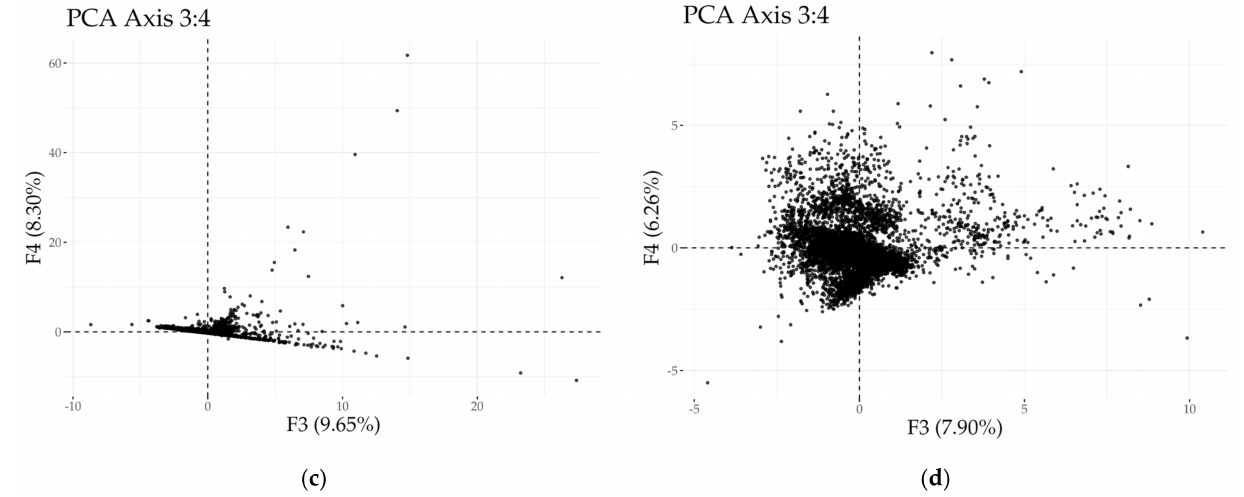
Figure 4. Distribution of the observations in factorial plans F1 − F2 and F3 − F4 for: ( a , c ) raw data; ( b , d ) log-transformed data. Table 1. Contribution of the parameters to the first five factorial axes (PCA with log-transformed data). F1 F2 F3 F4